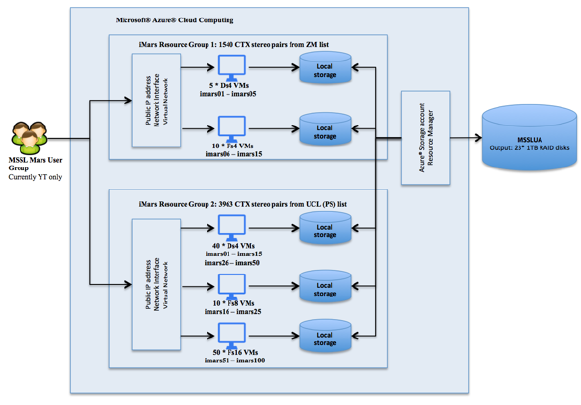
Figure 5. Microsoft® Azure® cloud computing set-up running on low specification Virtual Machines. See [4] for further